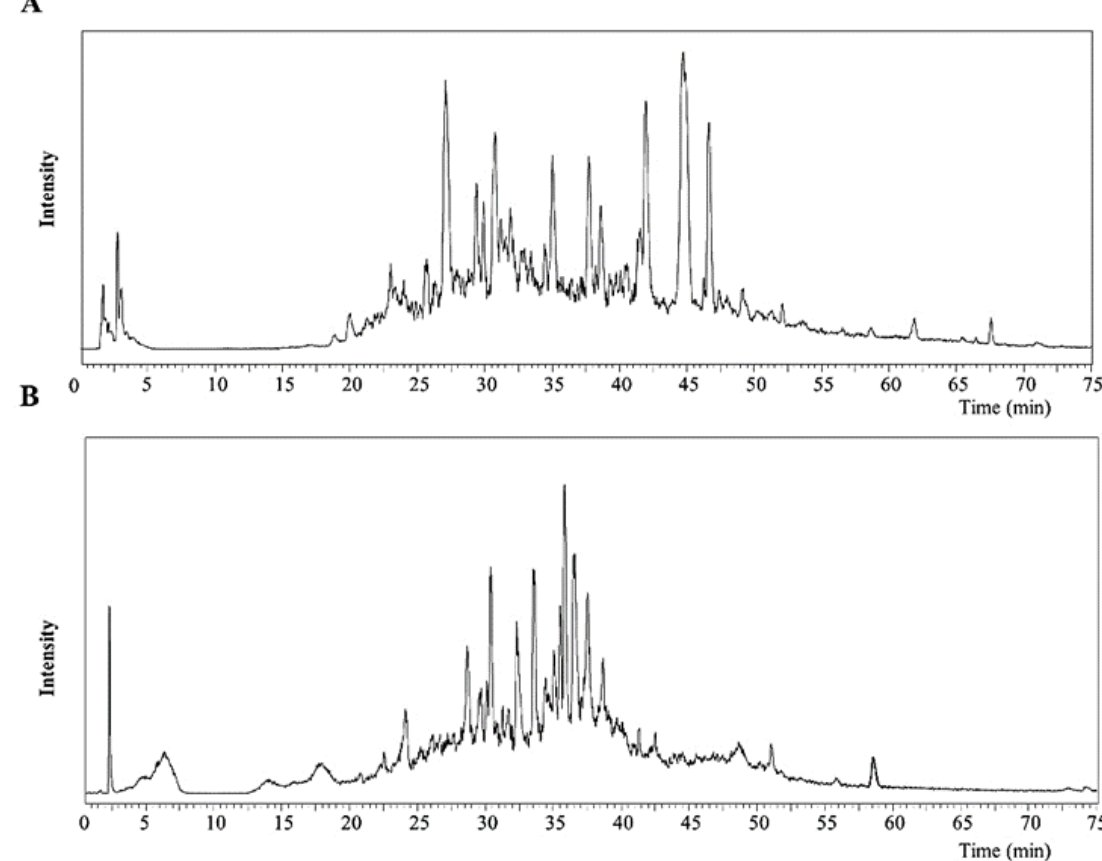
Figure 2. LC/MS chromatograms of (A) native and (B) Cys-alkylated C. taeniatus venom.